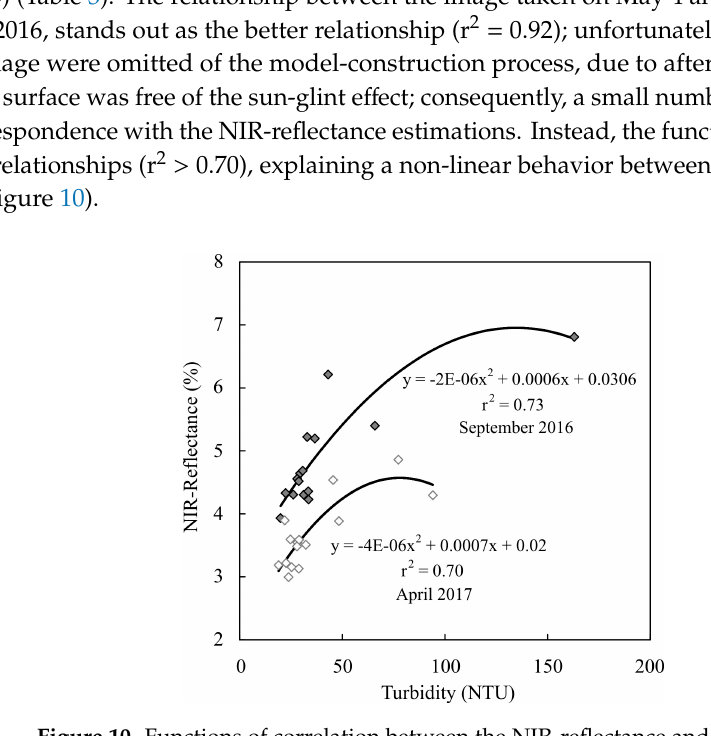
Table 3. Elements and criteria to carry out the model calibration.